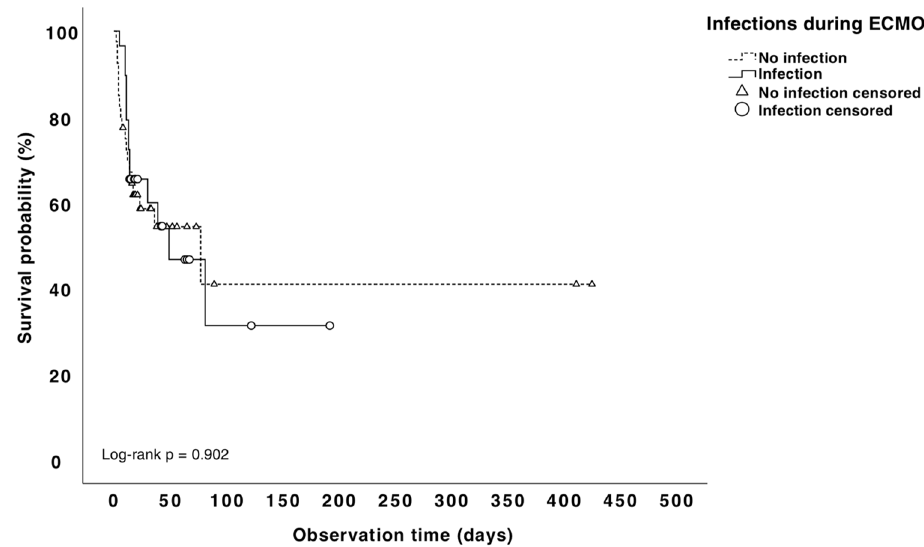
Figure 2. Kaplan–Meier mortality rates for patients with and without nosocomial infection. Table 4. Univariate analysis of the risk factors for mortality.